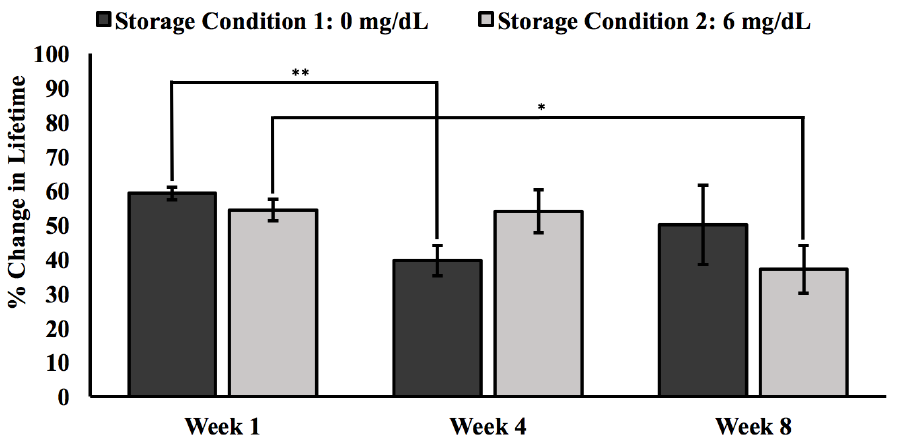
Figure 6. Response of urate biosensors stored in 5 mg/dL urate solution dissolved in 10 mM PBS. Both solutions were stored at 25 °C and pH 7.4 over an eight-week period. Measurements were made at the beginning, middle, and end points of the eight-week period. Error bars represent 95% confidence intervals. A single asterisk indicates a p value of 0.05 or less, while a double asterisk denotes a p value of 0.01 or less.